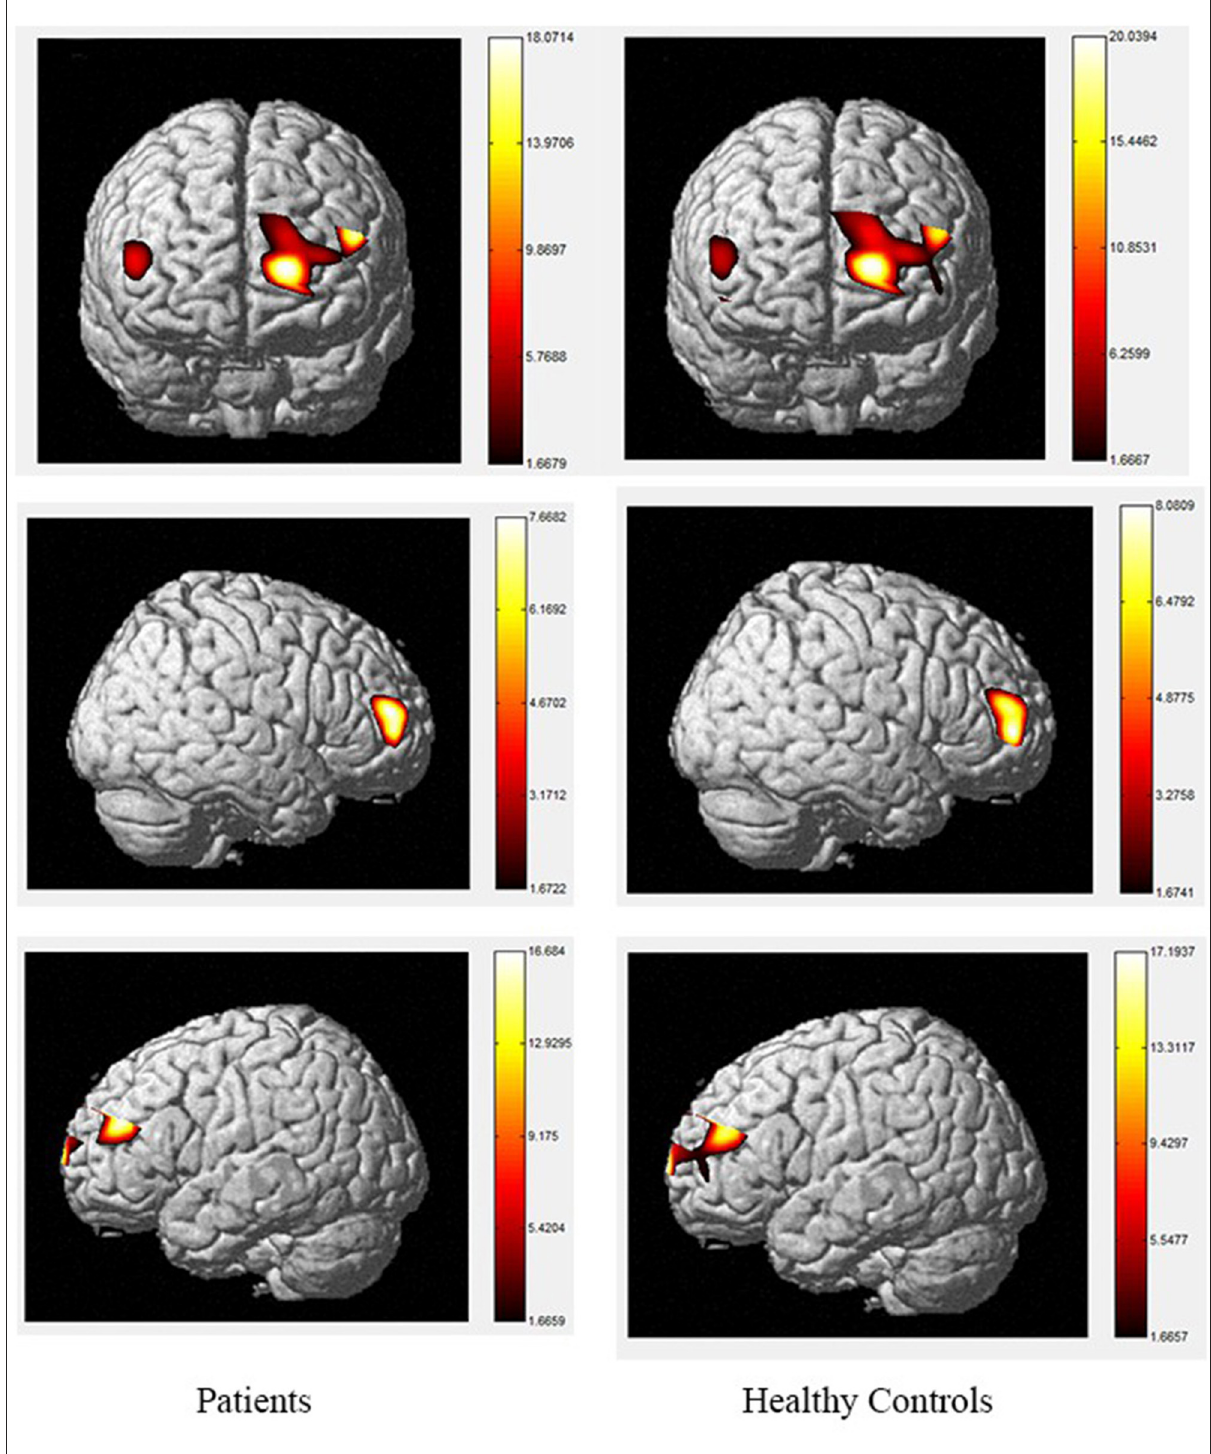
FIGURE3 The activation of brain areas during the color word inconsistency Stroop tasks between patients and healthy controls. The color bars in right sides mean the activated strength of brain